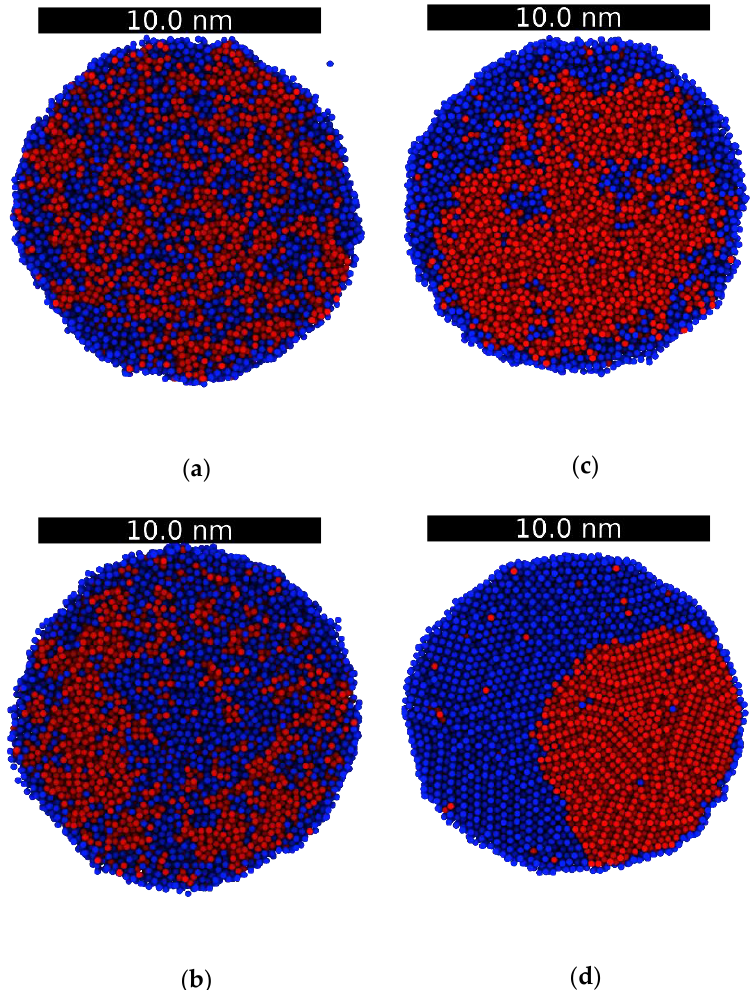
Figure 8. Cross sections of the droplets at 2000 K ( a ), 1800 K ( b ), 1600 K ( c ), and 800 K ( d ). Color code: Ni, red and Ag, blue.